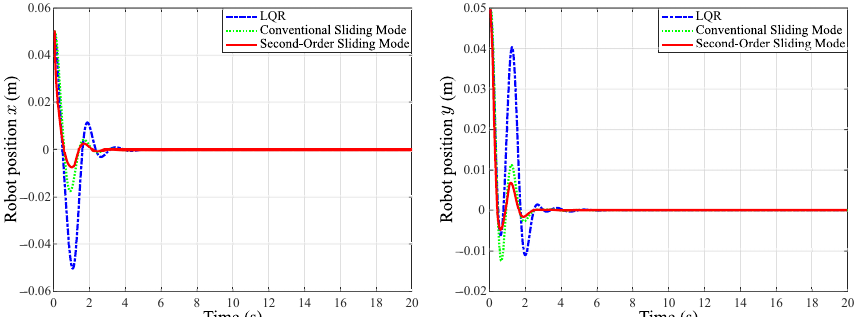
Figure 7. The simulation results of the rotary inverted pendulum compare the robot’s position responses on the X -axis and Y -axis, respectively.